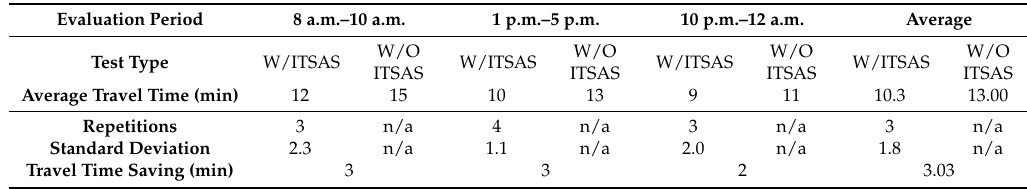
Table 1. Field test